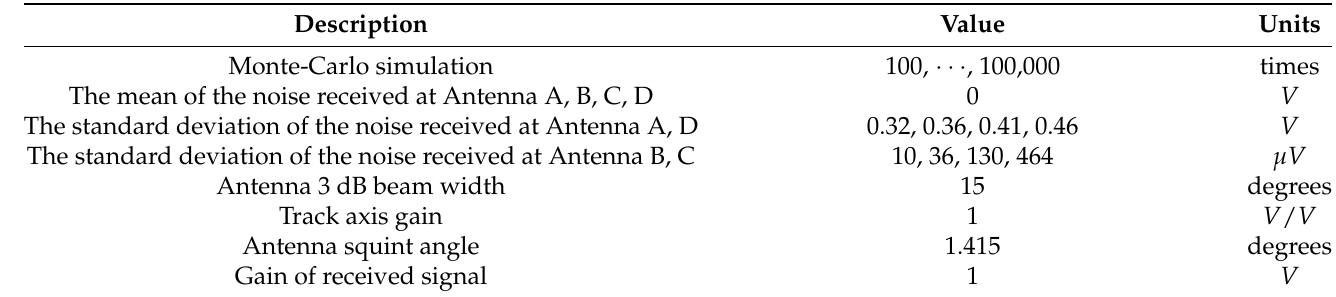
Table 3. Parameters for Test 2.